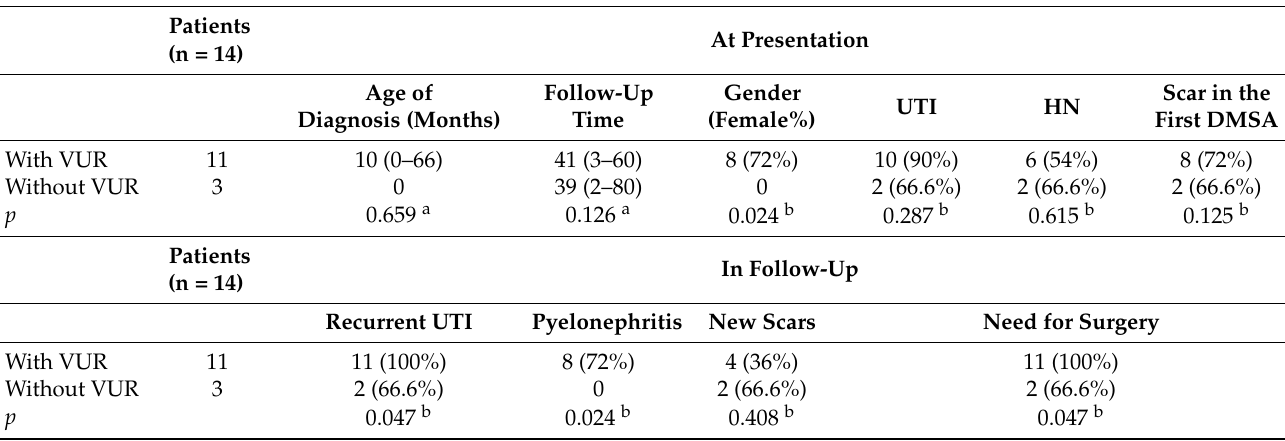
Table 2. Comparing patients with or without VUR among 14 with a double collecting